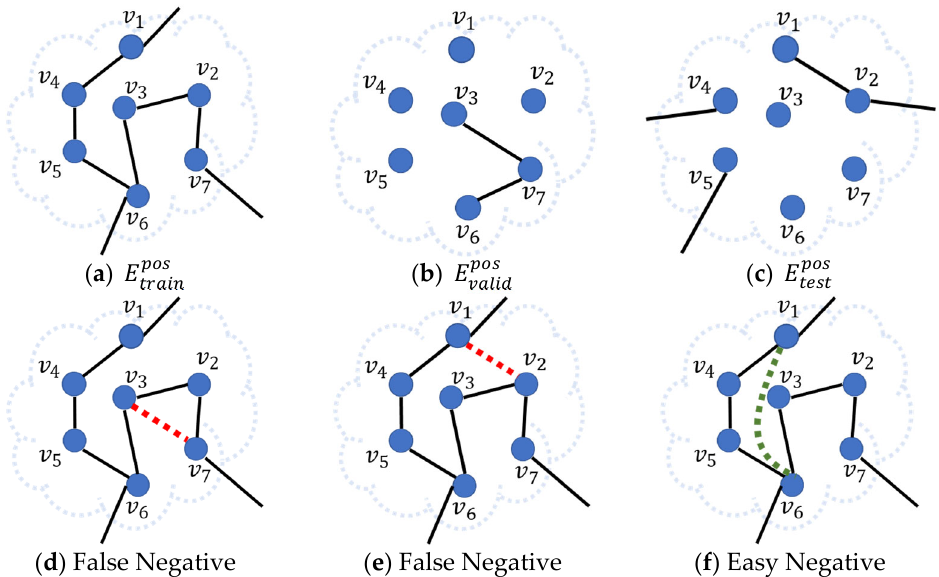
Figure 1. Examples of false and easy negative samples. Edges in ( a – c ) represent the edges in 𝐸 (cid:3047)(cid:3045)(cid:3028)(cid:3036)(cid:3041)(cid:3043)(cid:3042)(cid:3046) , 𝐸 (cid:3049)(cid:3028)(cid:3039)(cid:3036)(cid:3031)(cid:3043)(cid:3042)(cid:3046) and 𝐸 (cid:3047)(cid:3032)(cid:3046)(cid:3047)(cid:3043)(cid:3042)(cid:3046) , respectively. The missing edges, including edge (cid:4666)𝑣 (cid:2871) , 𝑣 (cid:2875) (cid:4667) in ( d ) and edge (cid:4666)𝑣 (cid:2869) , 𝑣 (cid:2870) (cid:4667) in ( e ), are sampled as negative samples, which mislead GNN models. The easily distinguishable edge (cid:4666)𝑣 (cid:2869) , 𝑣 (cid:2874) (cid:4667) in ( f ) is sampled as a negative sample, which contributes insufficiently to GNN models.